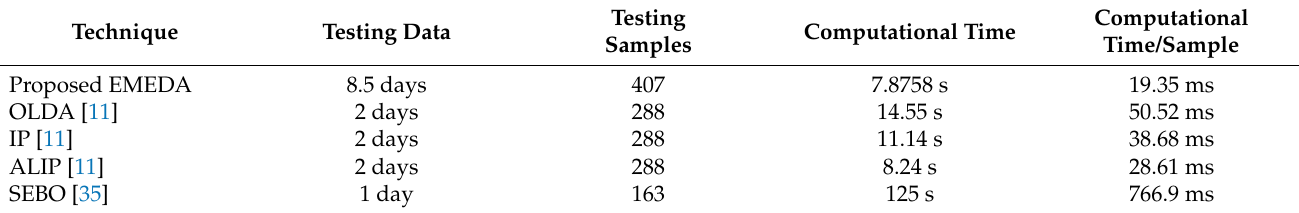
Table 7. Comparison of computational